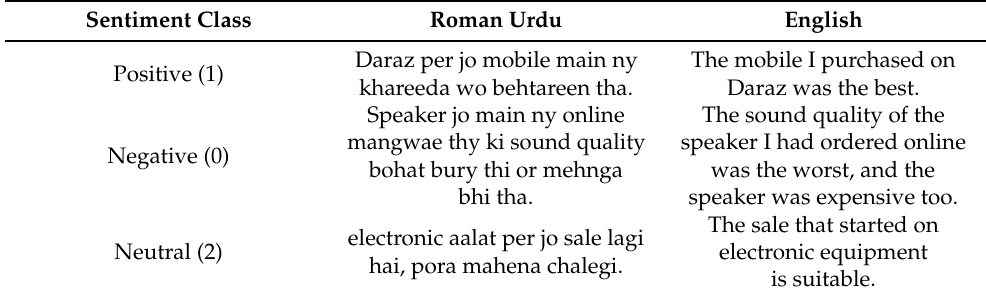
Table 1. Roman Urdu sample sentences with English translations belonging to the three classes. Sentiment